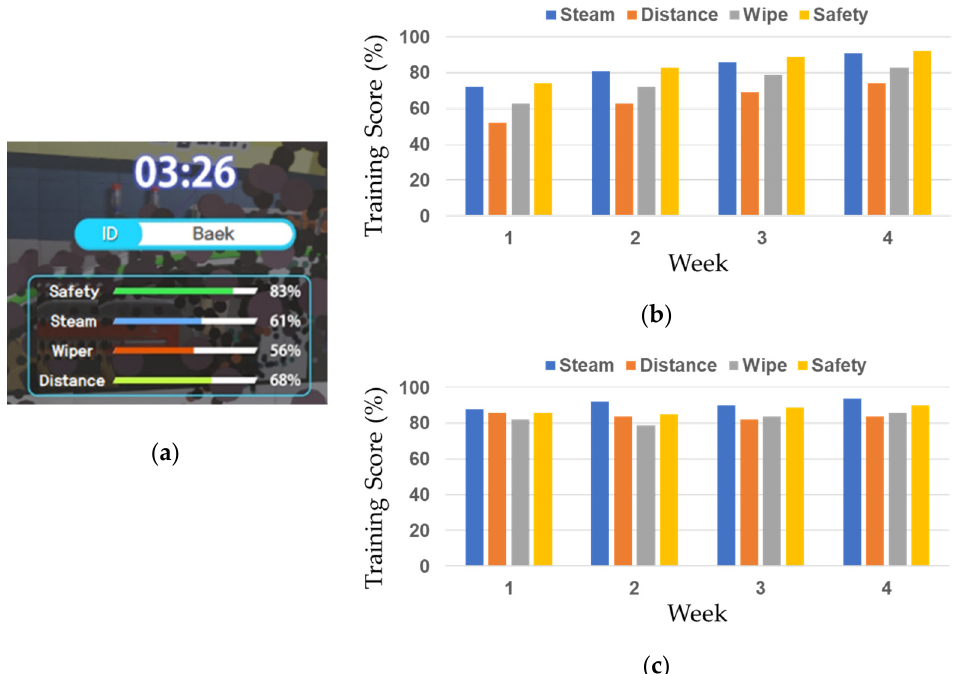
Figure 19. User case results: ( a ) Training scores; ( b ) Tangible interactions; ( c ) VR controllers.